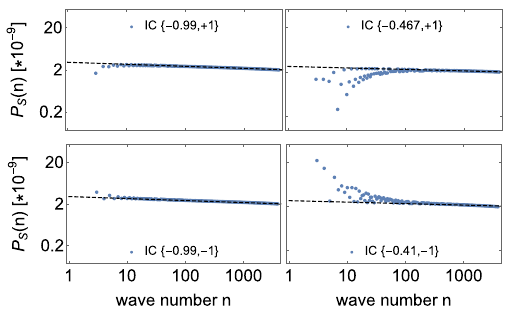
Fig. 8 Primordial scalar power spectrum for different sets of back- ground initial conditions, in the case of the quadratic potential and with fluctuations initiated before the bounce (blue dots). The dashed black line represents the standard power law. The IC for the background are: top left {− 0 . 99 , + 1 } , top right {− 0 . 467 , + 1 } , bottom left {− 0 . 99 , − 1 } , bottom right {− 0 . 41 , − 1 }